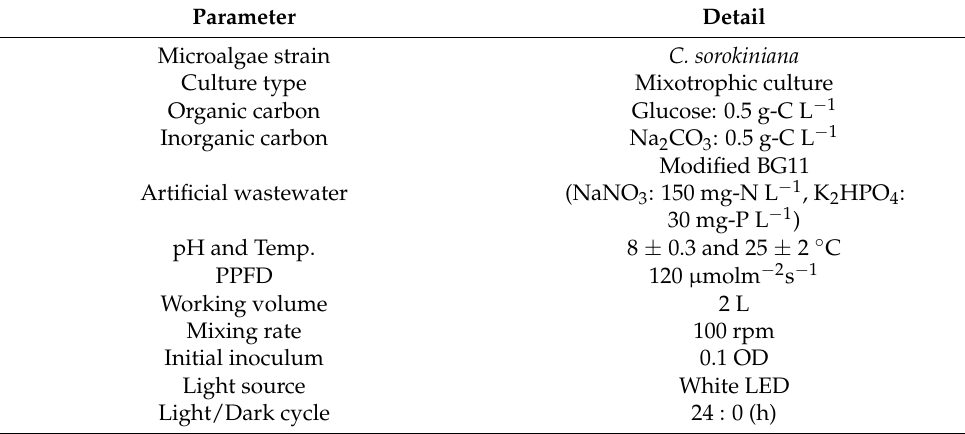
Table 1. Experimental conditions of a photo-bioreactor in a mixotrophic culture. Parameter Detail Microalgae